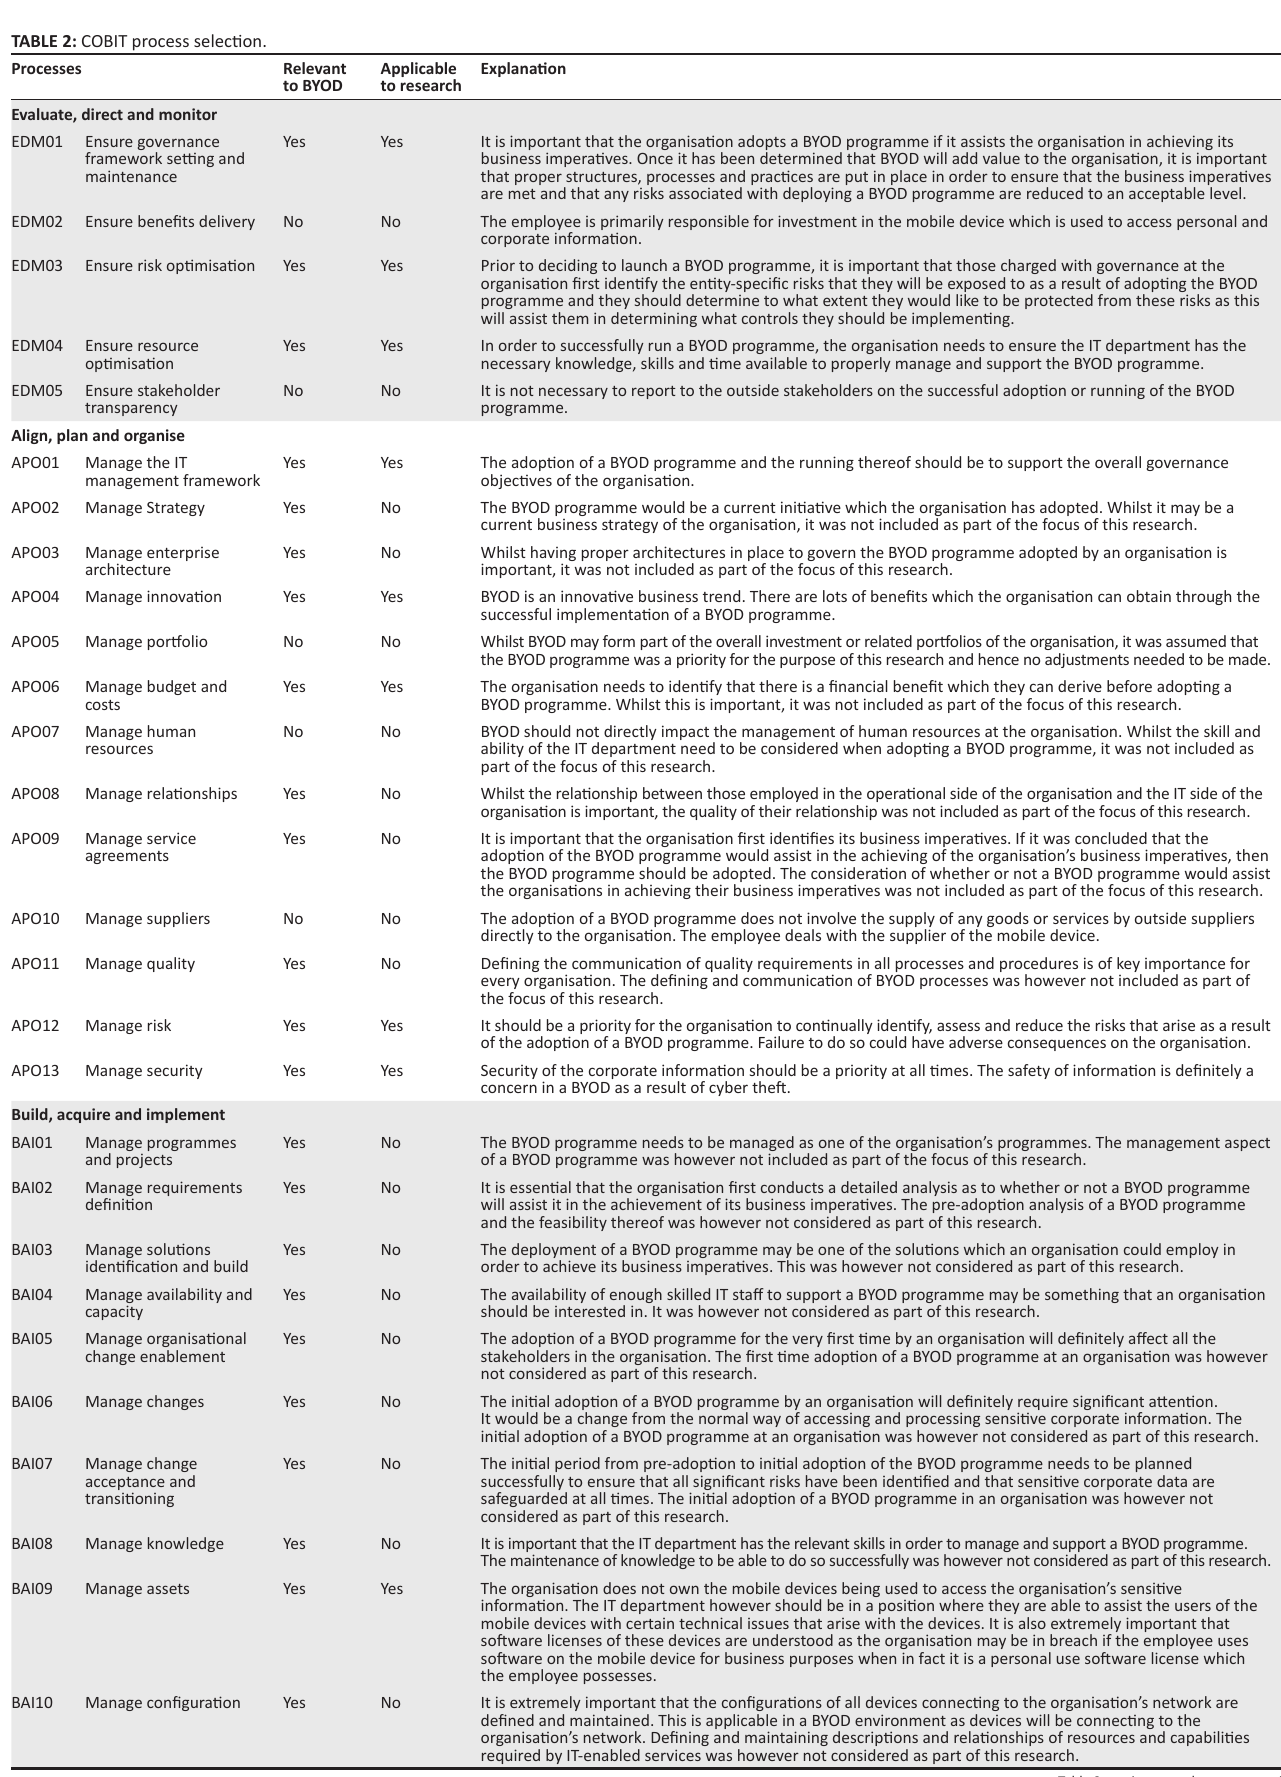
Applicable Explanation to BYOD to research